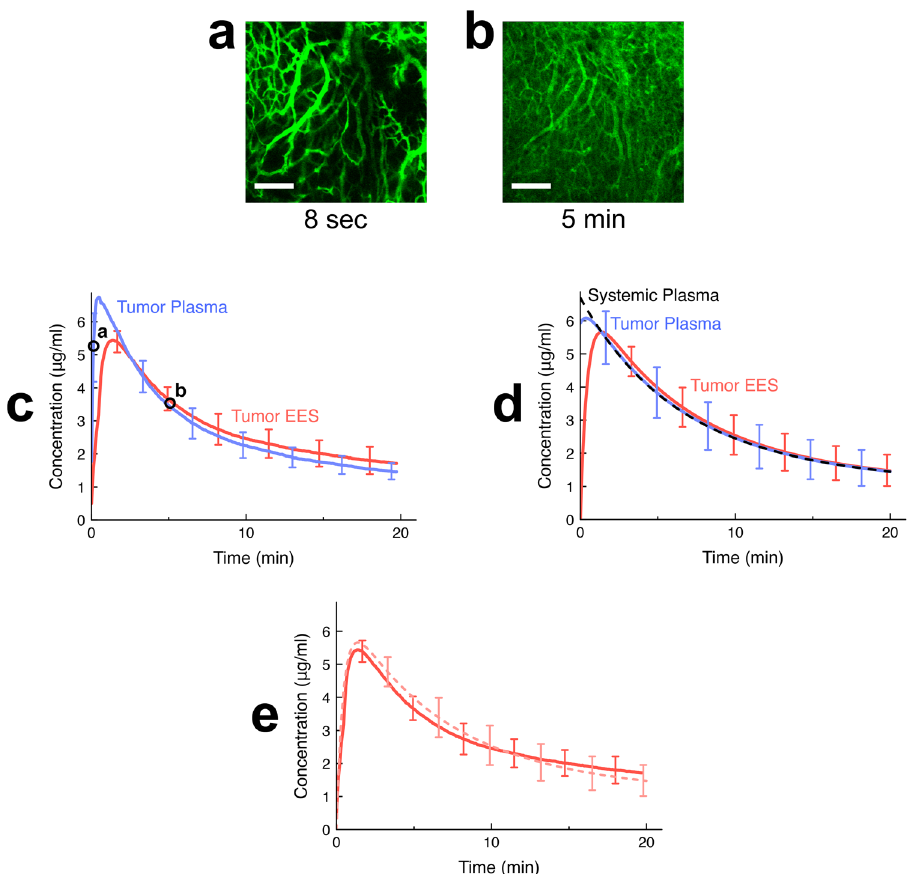
Fig. 2 Delivery kinetics of unencapsulated dye in vivo and in computer model. A bolus of unencapsulated fl uorescent dye (carboxy fl uorescein (CF)) was administered to tumor-bearing mice. a Intravital microscopy visualizes arrival of dye in the tumor vasculature, here shown 8 s after injection. Scale bar indicates 200 μ m. b Uptake of dye by tumor extravascular-extracellular space (EES) is apparent, shown 5 min after injection. The whole image time series is available as Suppl. Movie 1. c Mean dye concentrations in plasma and EES in imaged tumor segment were extracted from imaging data (image acquisition every 4s). Time points of microscopy images shown in ( a , b ) are indicated by circles. Error bars indicate standard deviation ( n = 3 animals). d